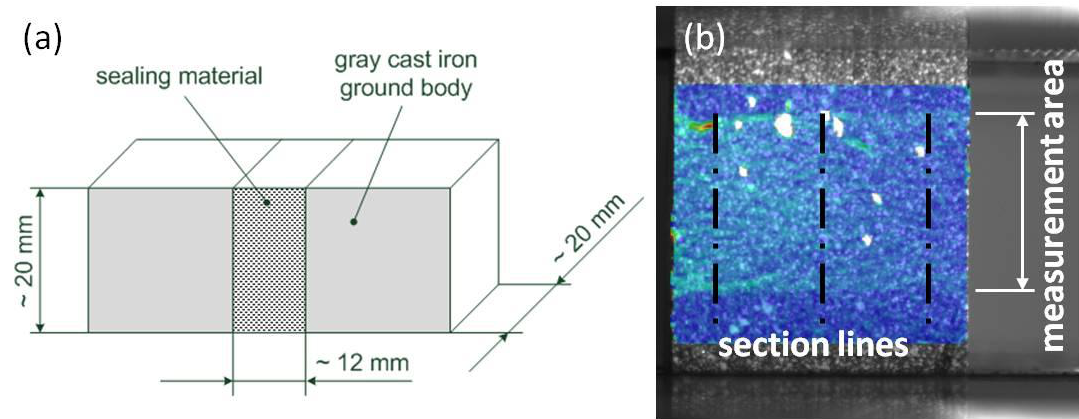
Figure 7. ( a ) Built up of the adhesion tensile test samples; ( b ) Scheme for determining the major strain at crack initiation from 2D-image correlation analysis.